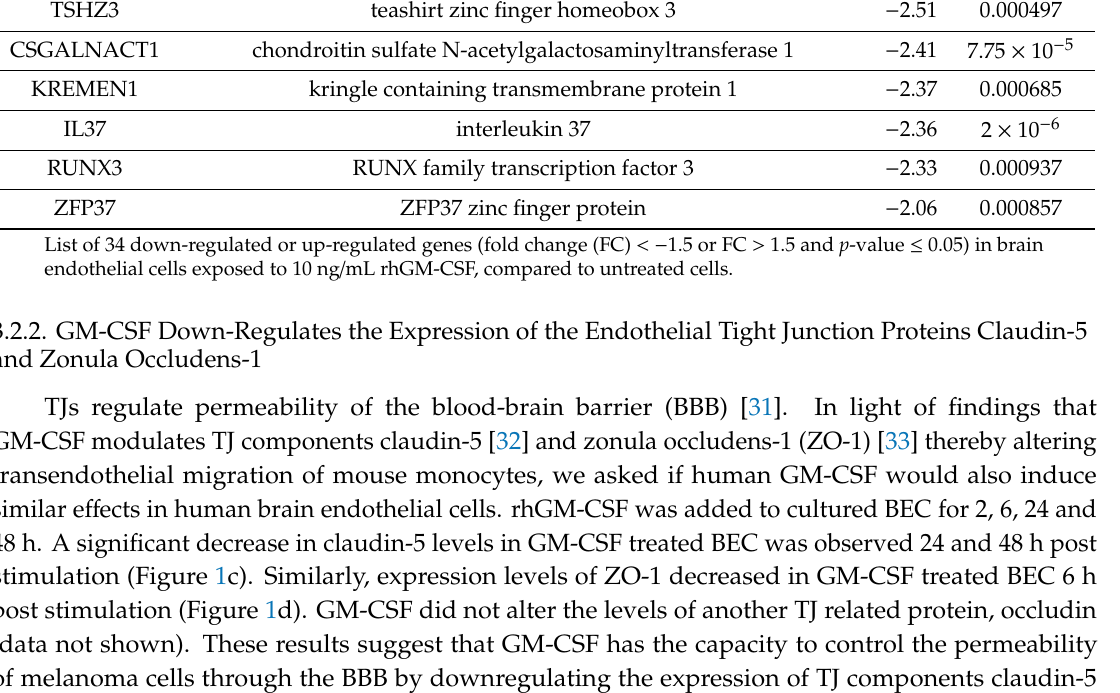
Figure 2. Regulation of melanoma-derived GM-CSF by brain microenvironment-secreted factors. ( a-h ) Extracellular levels of GM-CSF were estimated by ELISA analysis. (a,b) 5x10 5 YDFR.C, YDFR.CB3 ( a ), DP.C and DP.CB2 ( b ) cells were cultured for 24 h. The bars represent GM-CSF levels in 15-fold concentrated supernatants (pg/mL). ( c , d ) 5x10 5 YDFR.CB3 ( c ) or DP.CB2 ( d ) cells were treated with microglia-CM (MG-CM), brain endothelial cell-conditioned medium (BEC-CM) or astrocyte-conditioned medium (HA-CM). After 4 h, cells were cultured in starvation medium for 20 h. Treatment with starvation medium was used as control (medium). ( e , f ) 5x10 5 YDFR.CB3 ( e ) and DP.CB2 ( f ) cells were simulated with rhIL-1α (1, 10 and 50 ng/mL) or rhTNF-α (1, 10 and 50 ng/mL) for 24 h. Unstimulated cells were used as control. Note: The scale of the two graphs is different. (g, h) 5x10 5 YDFR.CB3 cells were stimulated with either rhIL-1α ( g ) or rhTNF-α ( h ) (10 ng/mL) diluted in MG-CM (rhIL1 + MG-CM, rhTNF-α + MG-CM) or in starvation medium as control (rhIL1-1 α, rhTNF-α) for 4 h, then cultured in starvation medium for 20 h. For each of the experiments, the bars represent the relative GM-CSF levels normalized to control. All graphs represent an average of at least three independent experiments ± SD. * p < 0.05, ** p < 0.01, *** p < 0.001. 3.4. Brain-Derived Soluble Factors Alter GM-CSF Secretion from Brain-Metastasizing Melanoma Cells We next determined if brain microenvironmental cells are capable of modulating GM-CSF secretion from melanoma cells. Whereas BEC- and astrocyte-derived soluble factors did not alter GM-CSF secretion from the brain metastatic variant YDFR.CB3, microglia-derived soluble factors decreased GM-CSF secretion from these cells by ~25% (Figure 2c). Soluble factors from brain-microenvironmental cells elicited a different pattern of GM-CSF secretion from DP.CB2 cells. While BEC-derived soluble factors decreased GM-CSF secretion by 25%, astrocytes-derived factors increased GM-CSF secretion by 54%. Microglia-derived soluble factors did not alter GM-CSF secretion (Figure 2d).